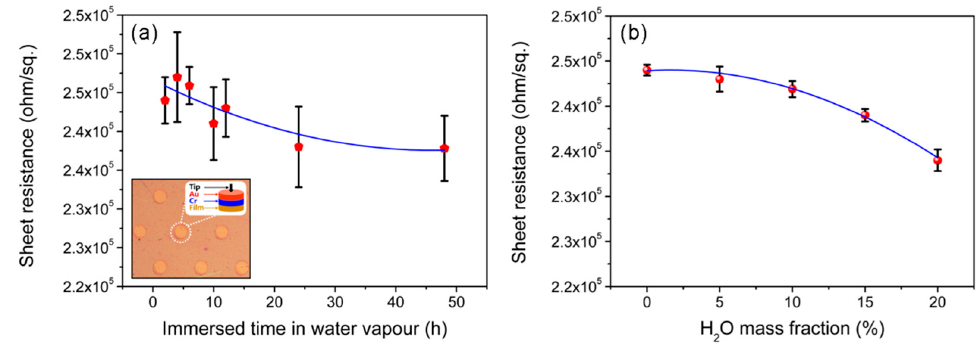
Figure 7. Sheet resistance variations with the swelling time ( a ) and the mass fraction of H 2 O ( b ).